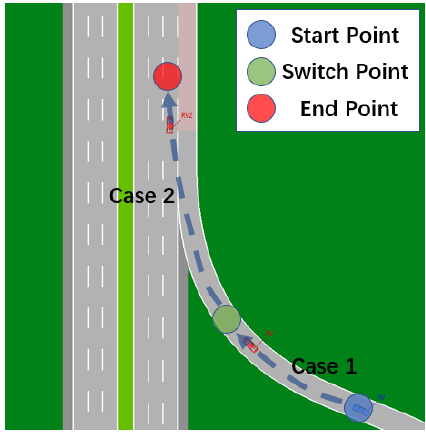
Figure 30. Road scenarios for continuity testing in VTD